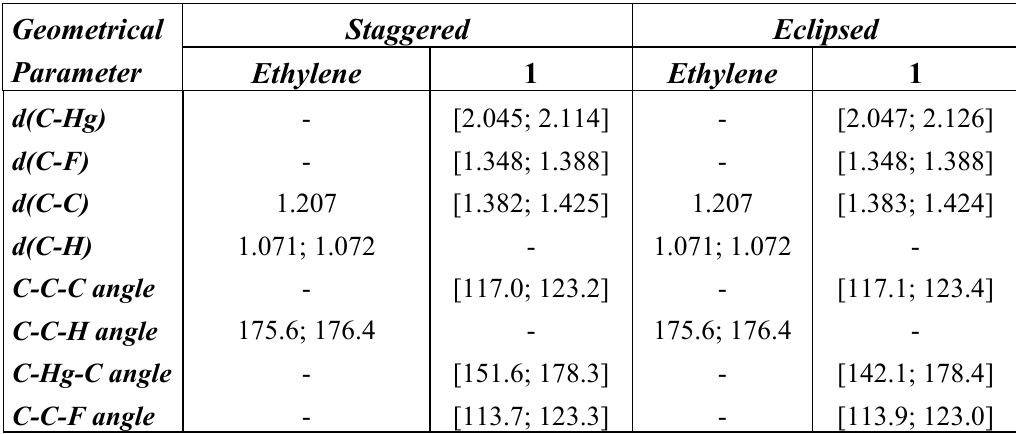
Table 4. Significant structural data for